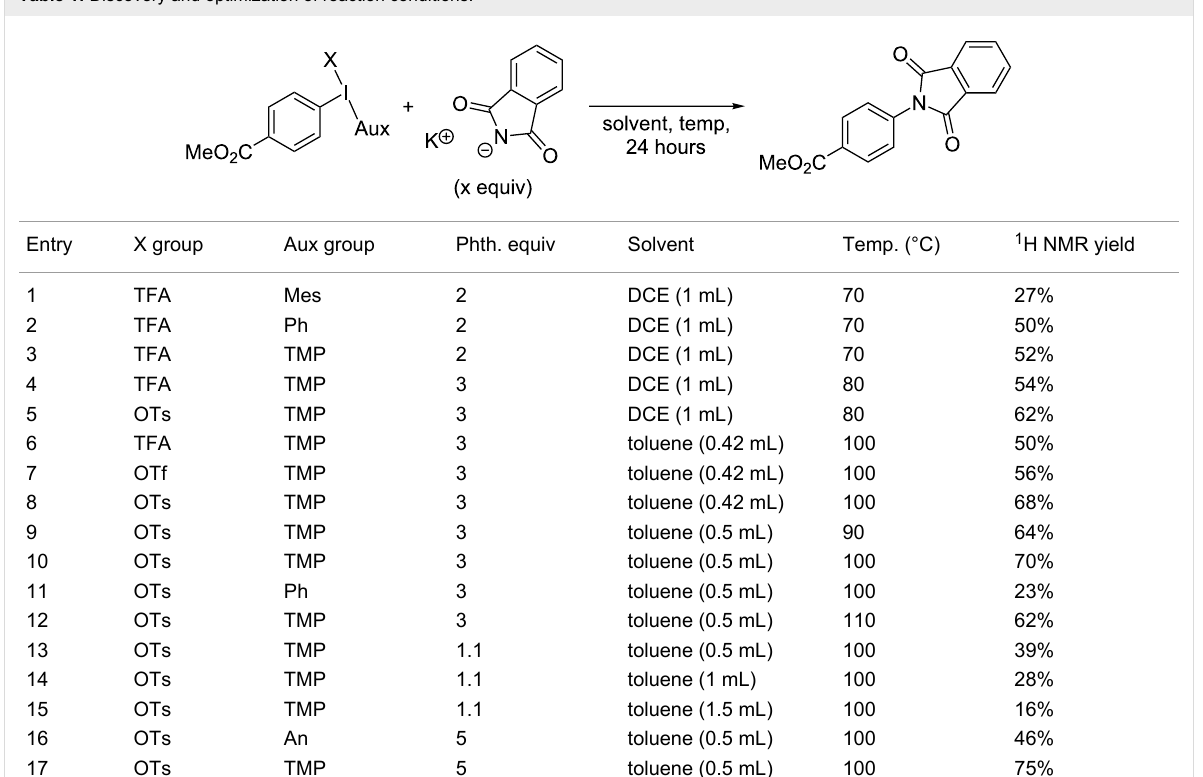
Table 1: Discovery and optimization of reaction conditions. a